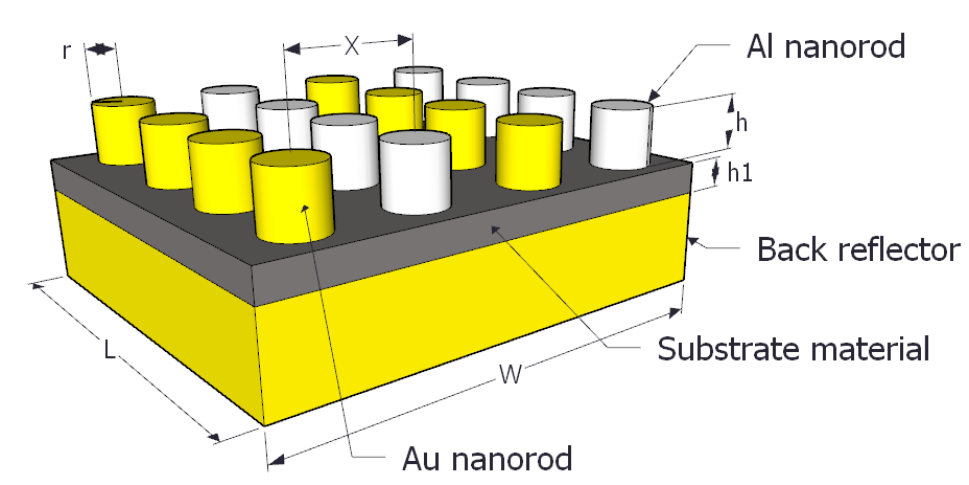
Figure 2. Absorption of the MMA structure.